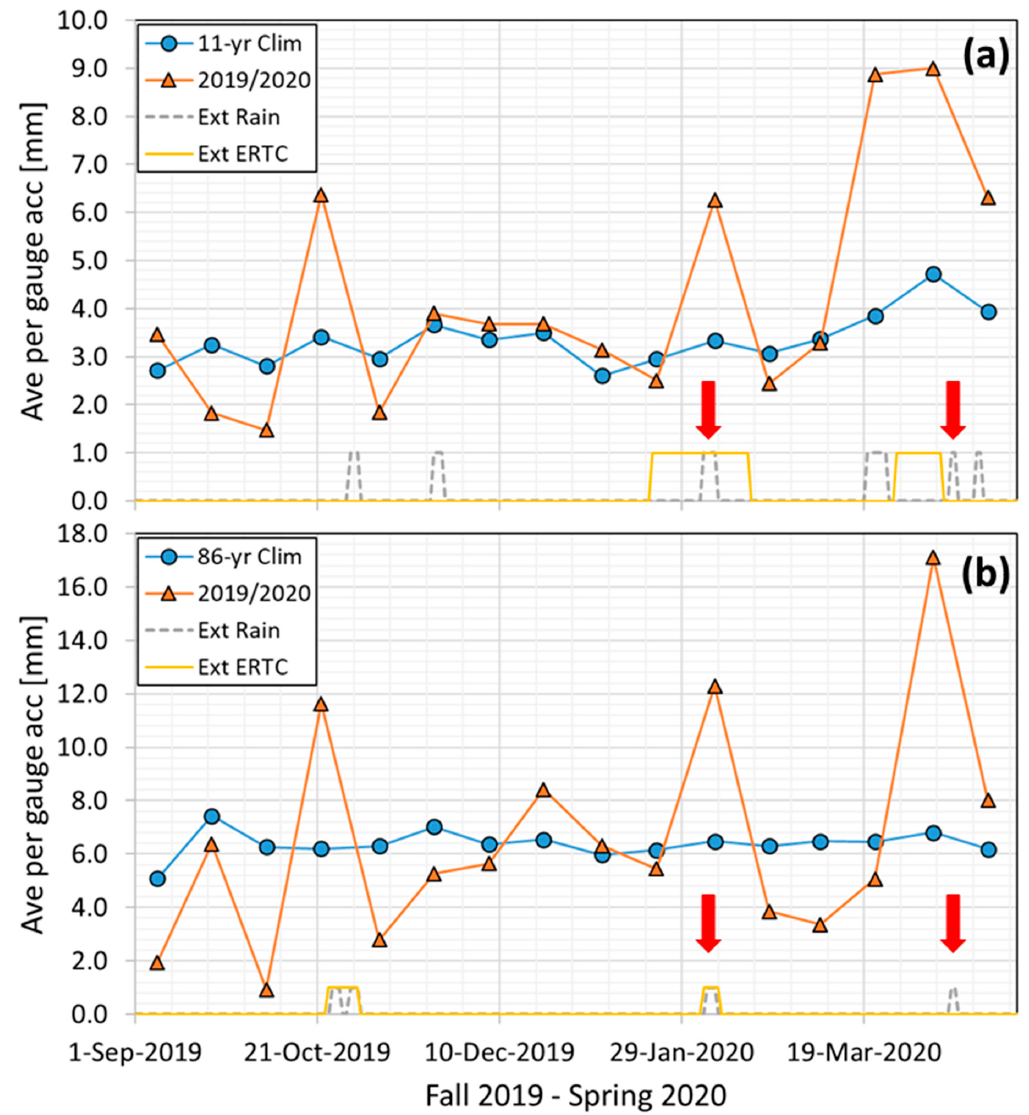
Figure 13. Bi-monthly average per gauge accumulation (mm) of the: ( a ) Duke GSMRGN located in the PRB; (11-year) and ( b ) CHLRGN located in the CRB (86-year) climatology (blue circles) and observed amounts for fall 2019-spring 2020 (orange triangles). Occurrence of extreme (top 2.5%) rain events (ExtR) and Elevated Rain Time Clusters (Ext ERTCs) of the watersheds over the period plotted at the bottom of the panels as dashed grey and solid gold lines, respectively. The focus of this study is on the two ExtR events (5–7 February and 12–13 April 2020) highlighted in the panels with a red arrow. Note the difference in range of the ordinate axis between the